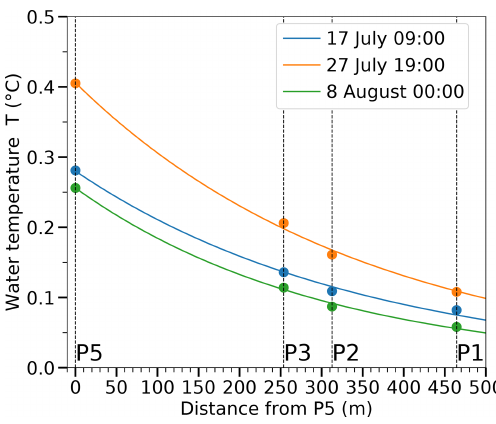
Figure 7. Temperature decrease along the channel flow path at three different times (CEST). Dots are observations; lines correspond to the fitted exponential law according to Eq. (11). Table 4. Dimensionless coefficients of the Dittus–Boelter equation (Eq. 9) from various studies, including this one (see Sect.